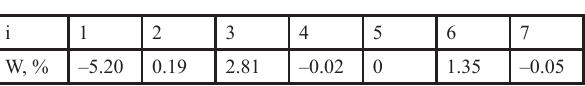
Table 1. W index values Tabela 1. Wartości wskaźnika W